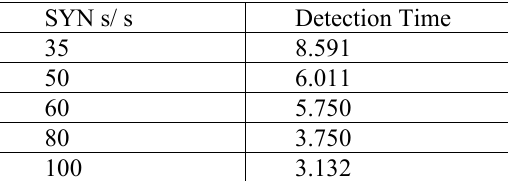
Table.1 Time taken for detecting the SYN flood under